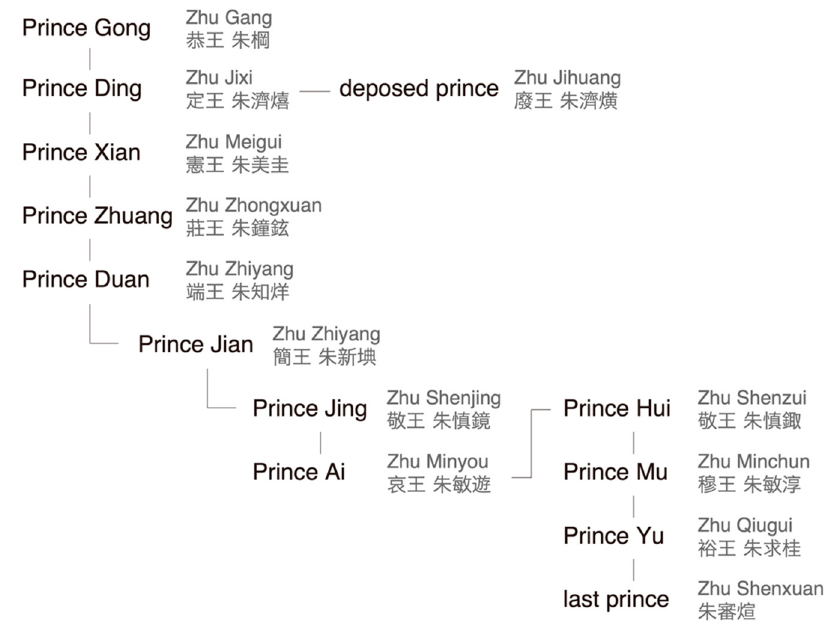
Figure 2. Simplified generations of the Princes of Jin (drawing by author).